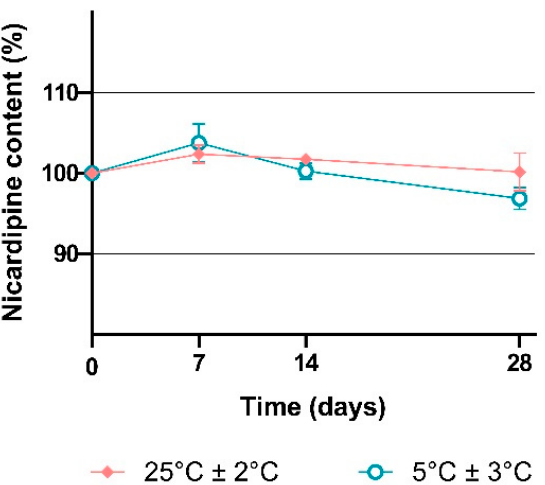
Figure 5. Chemical stability of nicardipine hydrochloride in compounded oral solution at 2 mg/mL for 28 days in “in-use conditions”. Note: Results are expressed as the mean of the nine samples (three test samples for each of the three batches), and error bars are defined as SD.